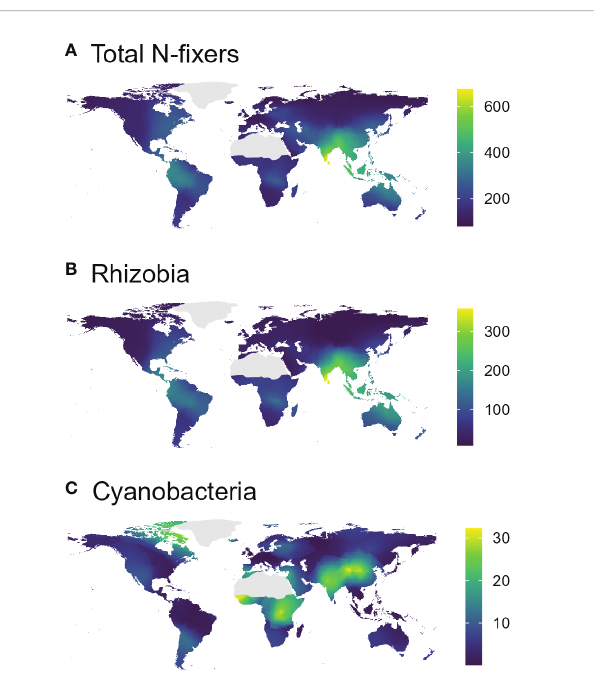
FIGURE 2 Interpolated (k-nearest-neighbour map cell interpolation based on the values from the collected samples, cell size = 0.5°×0.5°, k = 18) richness maps of total N- fi xers (A) , rhizobia (B) , and Cyanobacteria (C) , based on the nifH sequencing dataset.